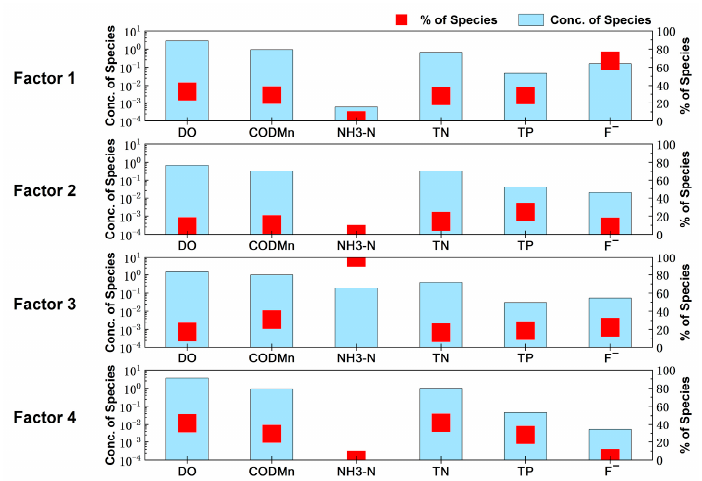
Figure 9. Source profile and contribution rate in the midstream. Table 8. Pollution source profile and contribution rate in the midstream.